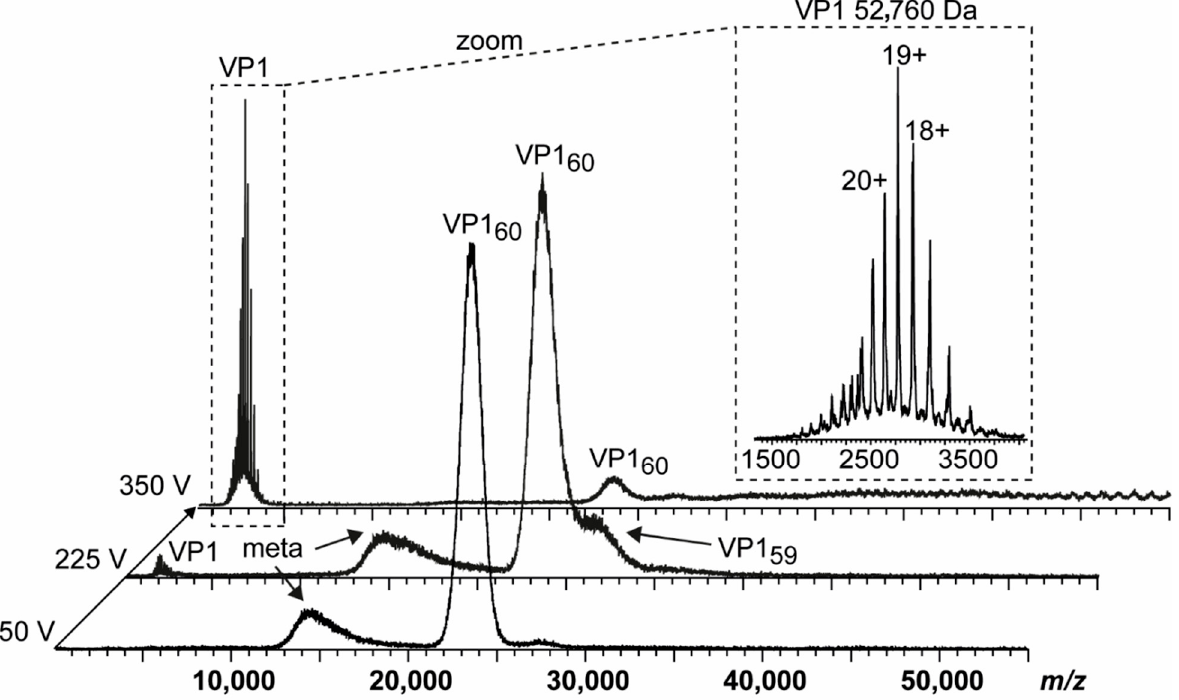
Figure 2. Native MS of a GI.1 West Chester batch forming merely VP1 60 complexes. Dissociation pathway without selection in the quadrupole is shown for GI.1 West Chester in 250 mM ammonium acetate pH 7 at 10 µM VP1. From bottom to top, illustrative mass spectra are shown for 50, 225, and 350 V acceleration into the collision cell. While at 225 V, VP1 monomers dissociate with the main population of VP1 60-mer still intact, the signal ratio of VP1 monomer:60-mer is reversed at 350 V. An insert shows a zoom of dissociated VP1 monomer with annotated charge states and average mass. As lower mass ions at approximately 15,000 m/z are annotated as metastable ions (meta), monomer lacking at least 40 aa most likely dissociate from T = 1 species.